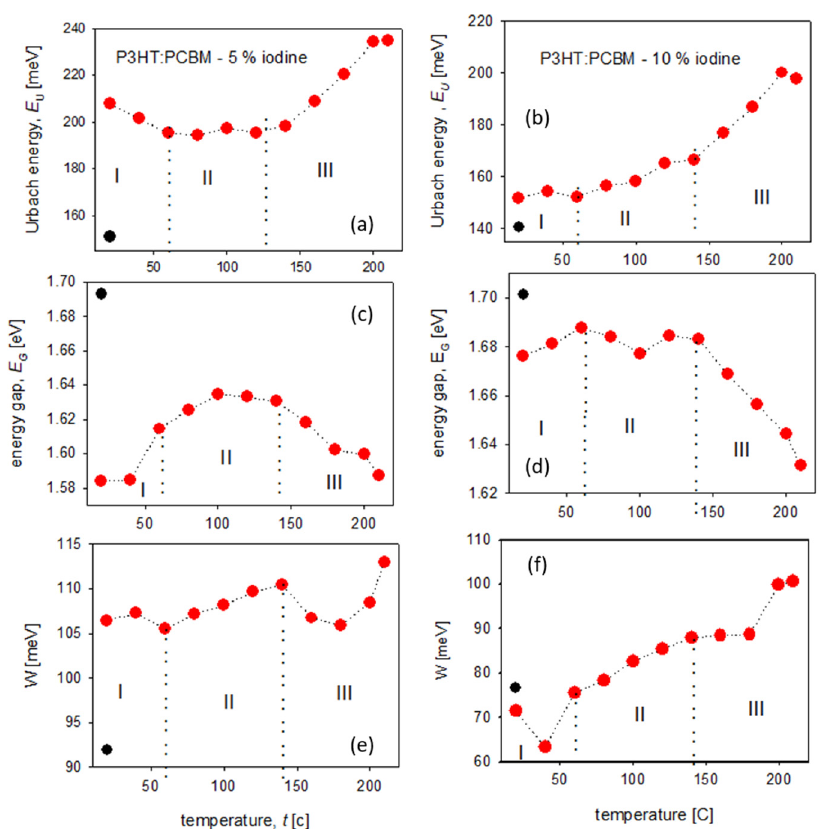
Figure 7. Temperature dependences of absorption edge parameters ( E U , E G ) and the exciton bandwidth ( W ) for 5% ( a , c , e ) and 10% ( b , d , f ) iodine-doped P3HT:PCBM blend films. (black points in figures mean the values at 20 ° C, after thermal treatment).